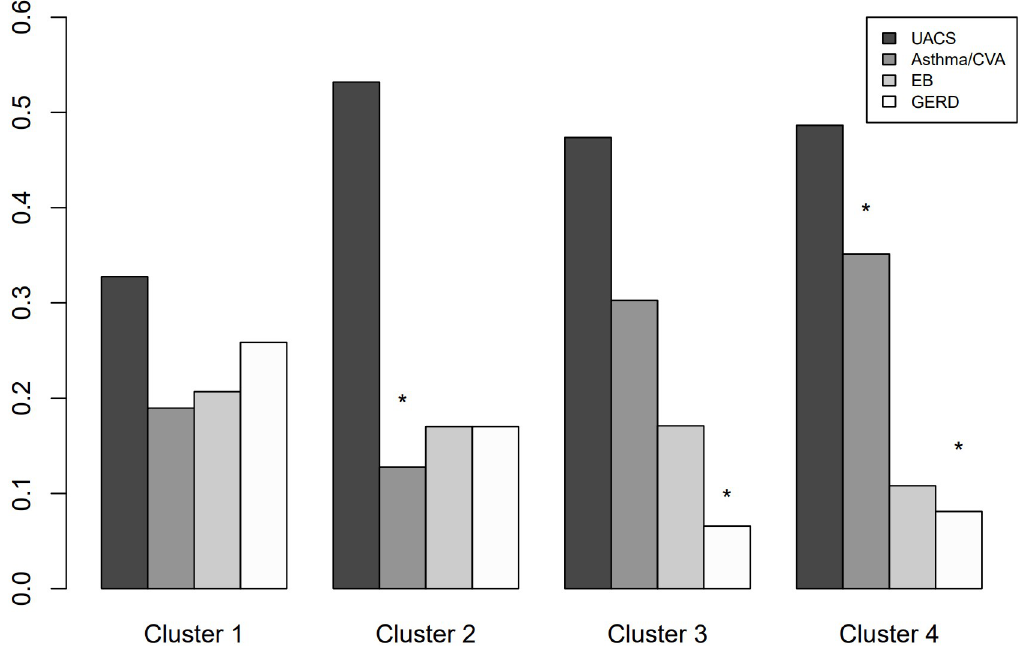
Fig 5. Proportion of each cause according to clusters. � Indicates statistical significance. Y axis means proportion of each etiology according to clusters (X axis). UACS, upper airway cough syndrome; CVA, cough variant asthma; EB, eosinophilic bronchitis; GERD, gastroesophageal reflux